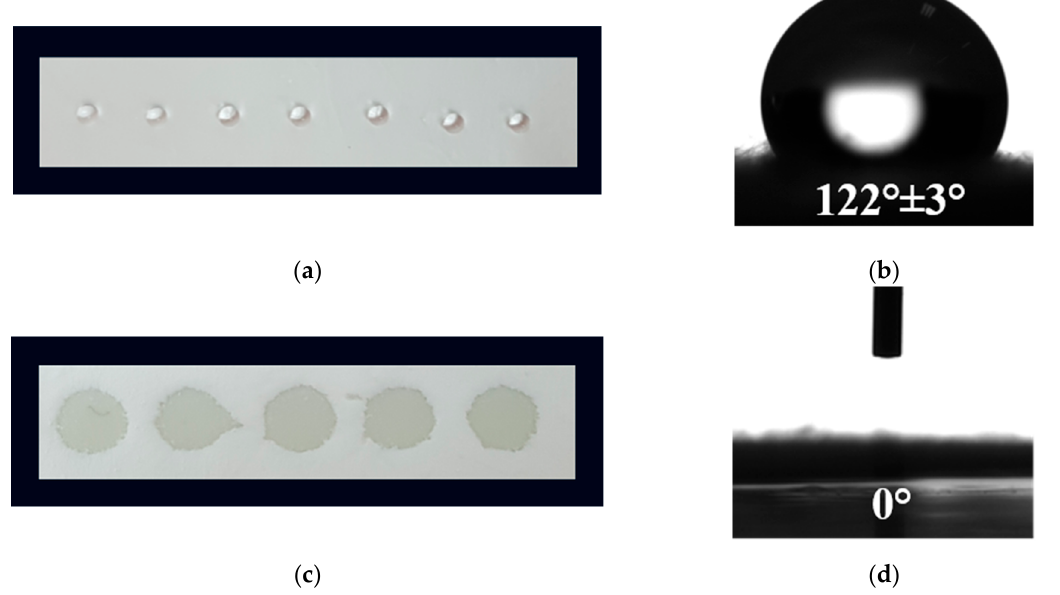
Figure 3. Digital photographs of distilled water drops (10 μ L) placed on surfaces of: ( a ) and ( b ) CA mats and ( c ) and ( d ) СА /PEG/QUE/RUT mats.